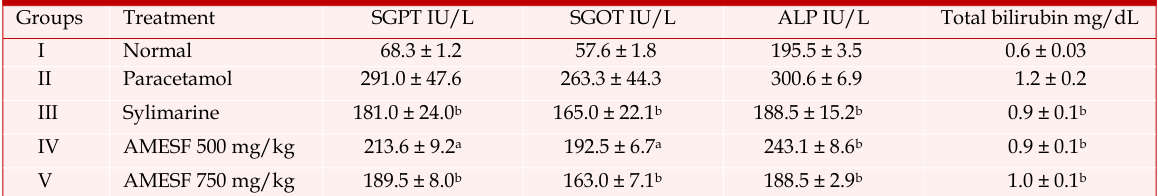
Effect of aqueous methanolic extract of S. fruticosa on biochemical markers